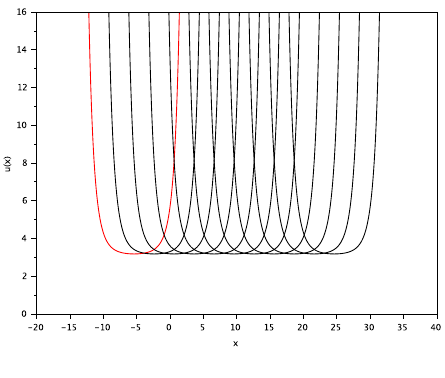
Fig. 6. The solution given by (34) plotted at t = [0 , 10] . The first curve is at t = 0 . The velocity front shifts to the right as time increases, moving as a traveling